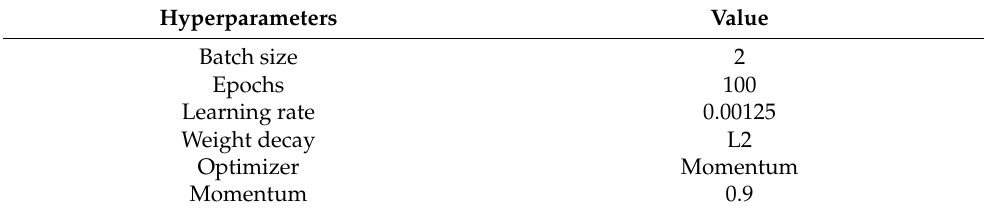
Table 6. Values of the training